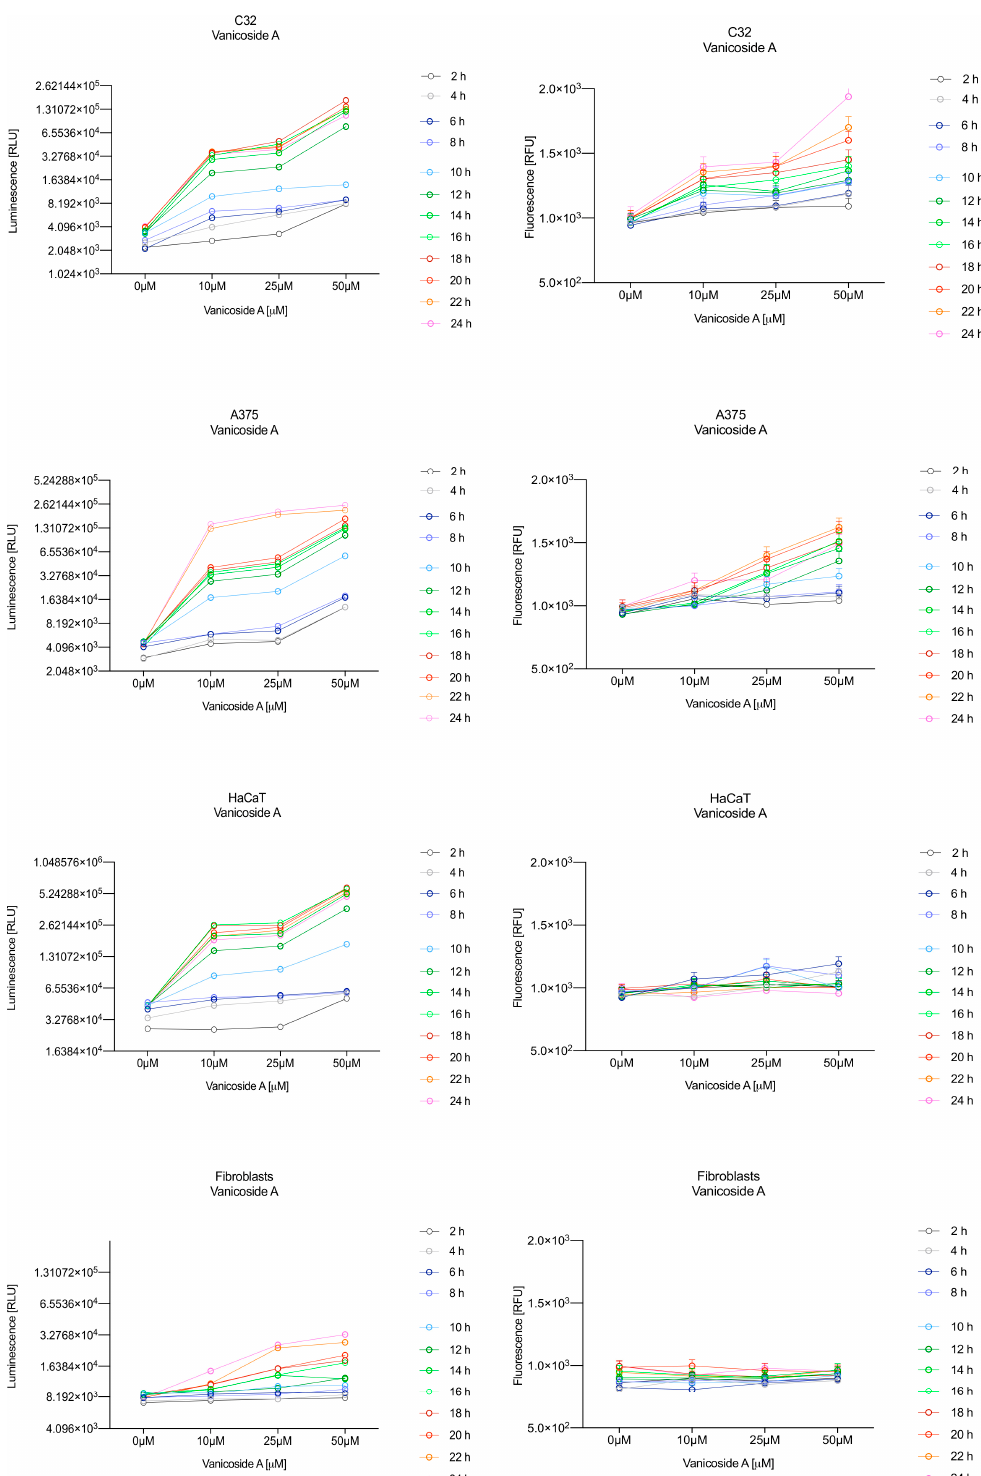
Figure 3. Repeated measurements of luminescence and fluorescence signals. C32, A375, HaCaT and fibroblast cell lines were exposed to serial dilutions of vanicoside A in the presence of RealTime-GloTM Annexin V Apoptosis and Necrosis Assay reagent. Relative luminescence units (RLU) (left panels, phosphatidylserine (PS): annexin V binding) and relative fluorescence units (RFU) (right panels; membrane integrity) were collected at indicated times. Data represent the mean of 3 readings for each replicate ± SD.